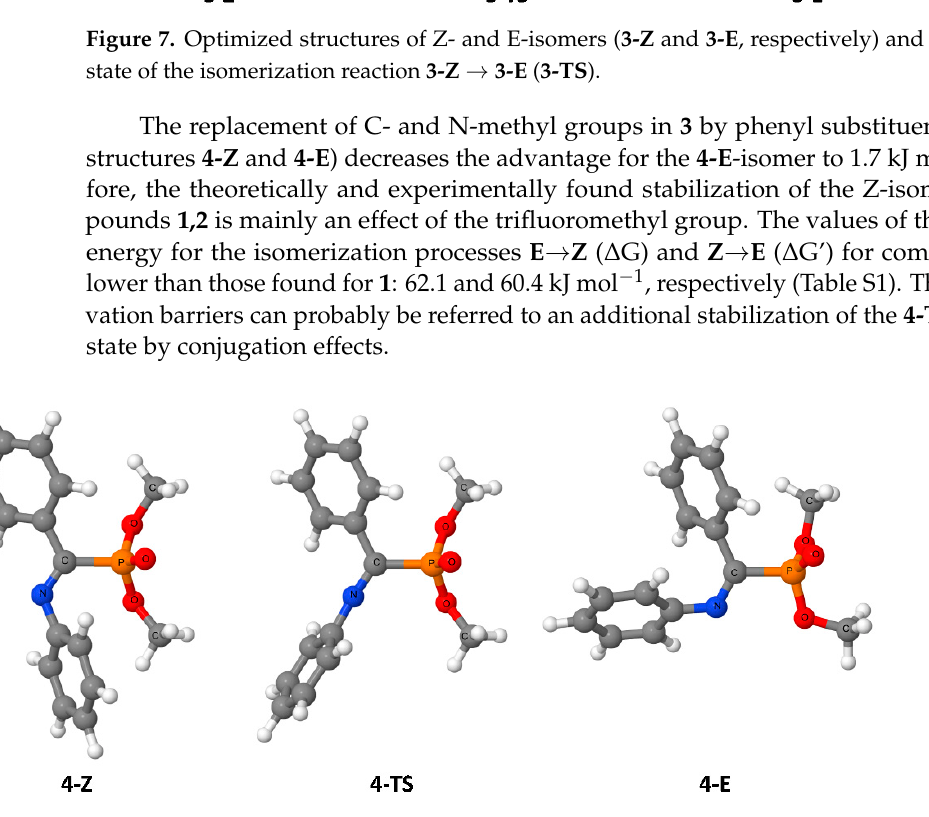
Figure 7. Optimized structures of Z- and E-isomers ( 3-Z and 3-E , respectively) and the transition state of the isomerization reaction 3-Z → 3- Е ( 3-TS ).